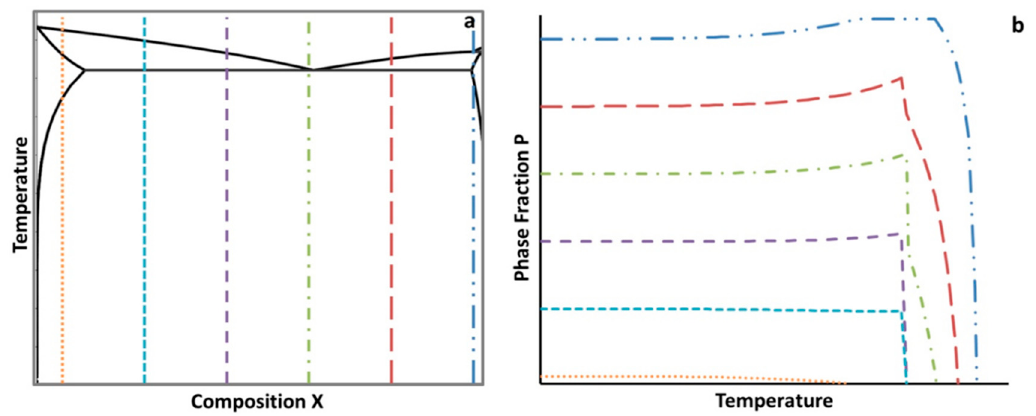
Figure 4. Schematic setup for the 𝜓 . ( a ) A schematic of an isopleth with varying temperature and composition of element X. The vertical lines represent contents of a hypothetically varied element, which was assigned the label X. ( b ) A schematic of the amounts of the imaginary equilibrium phase P predicted as a function of temperature with the corresponding composition change of X from ( a ).